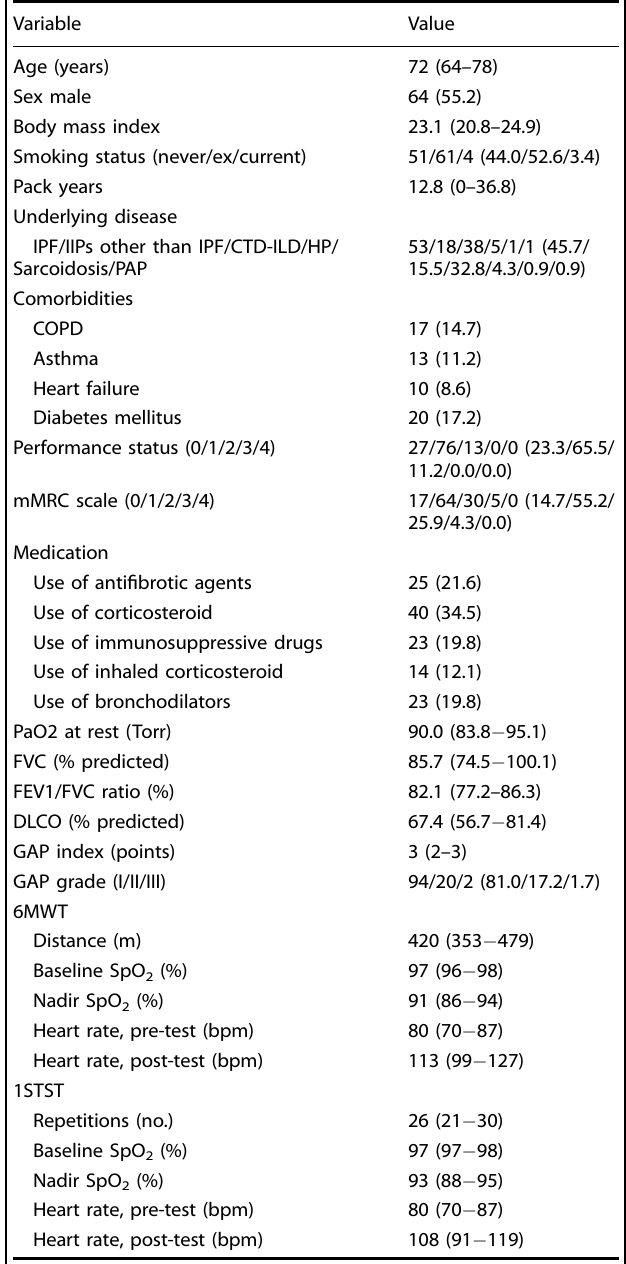
Table 1. Clinical characteristics of the study participants.